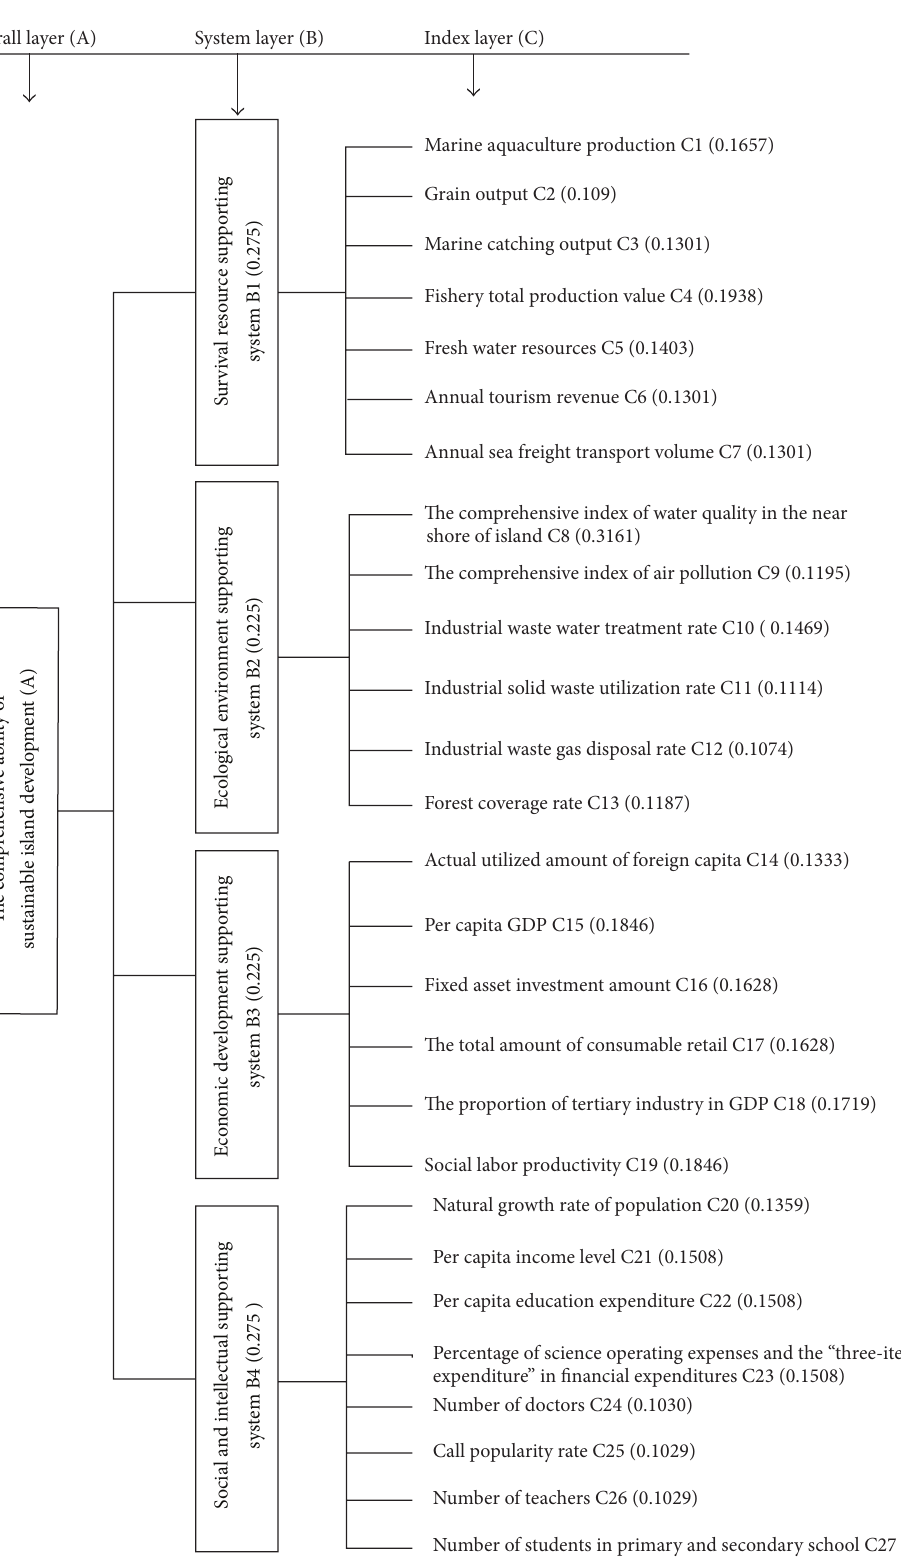
Figure 2: The evaluation index system of sustainable island